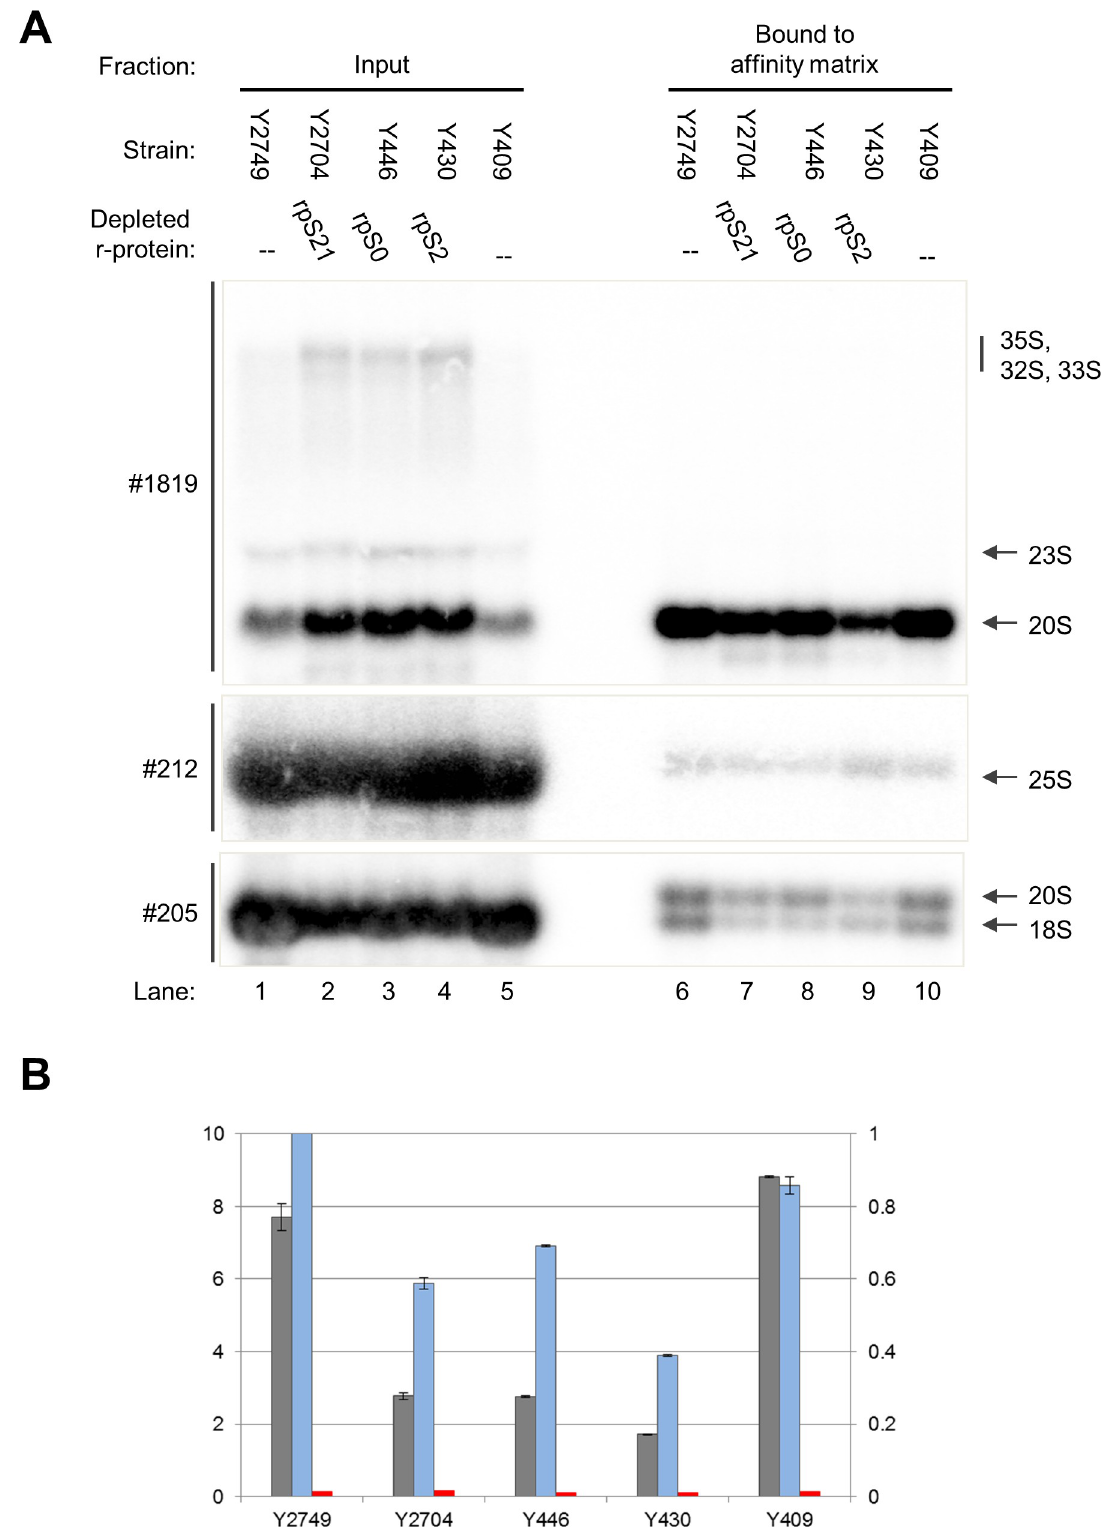
Fig 1. Association of Rio2 with SSU precursors depleted of S0-cluster proteins. The indicated yeast strains were cultivated for four hours in glucose containing medium to shut down expression of either rpS0, rpS2, rpS21 or no r-protein. TAP tagged Rio2 was affinity